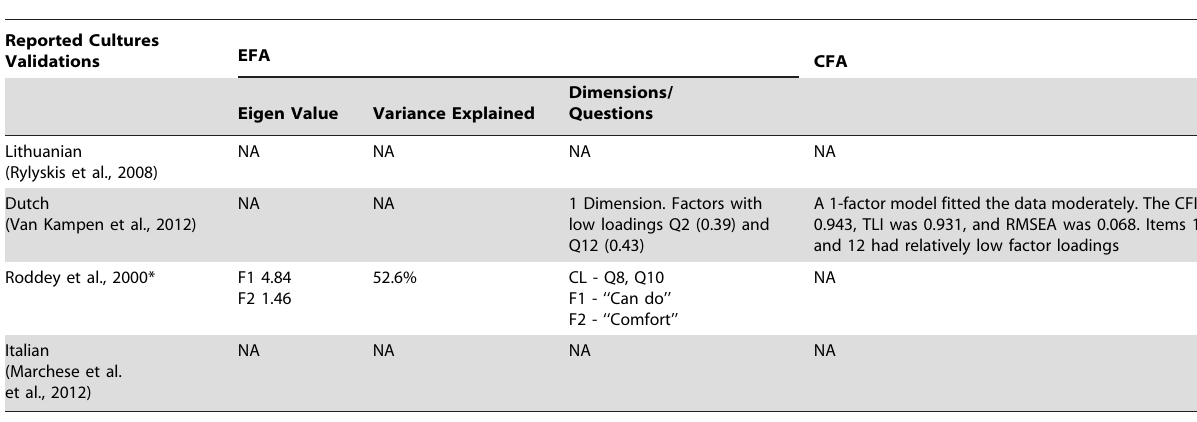
Table 2. Indicators of factor analysis of SST reported in previous literature.